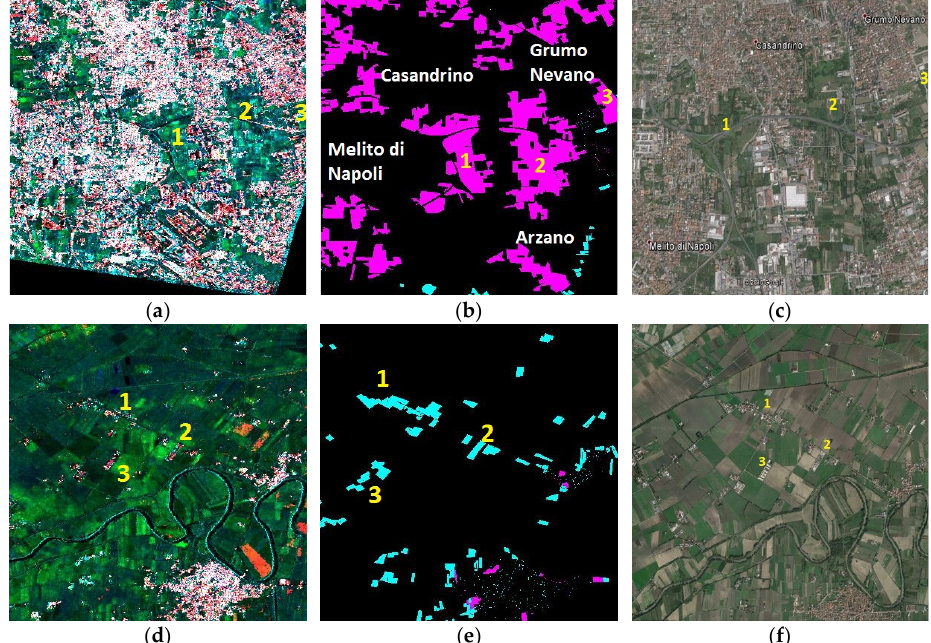
Figure 9. Napoli and Caserta areas, misclassification sources. ( a ) An agricultural area as seen on the Level-1α image. ( b ) Misclassification map. ( c ) Google Earth view. ( d ) A small urban area surrounded by a rural landscape as seen on the Level-1α image. ( e ) Misclassification map. ( f ) Google Earth view.